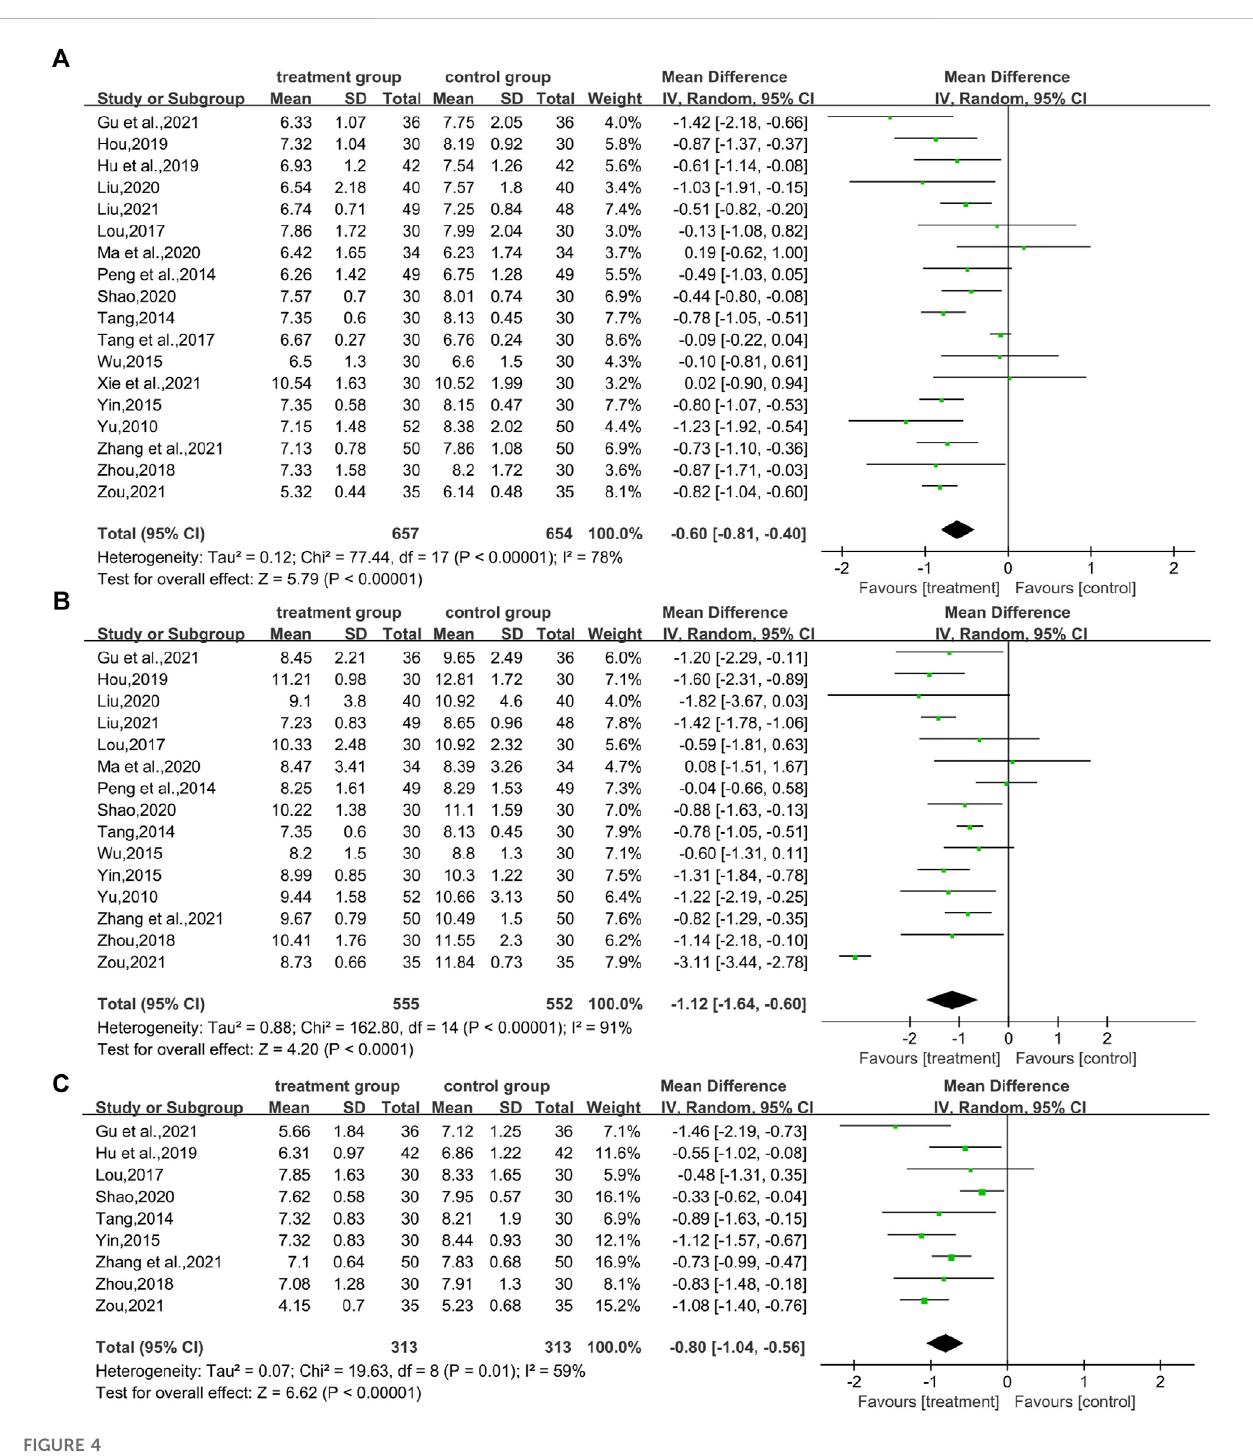
FIGURE 4 Forest plot for glucose metabolism. (A) FBG (B) 2hPG; and (C) HbA1c.